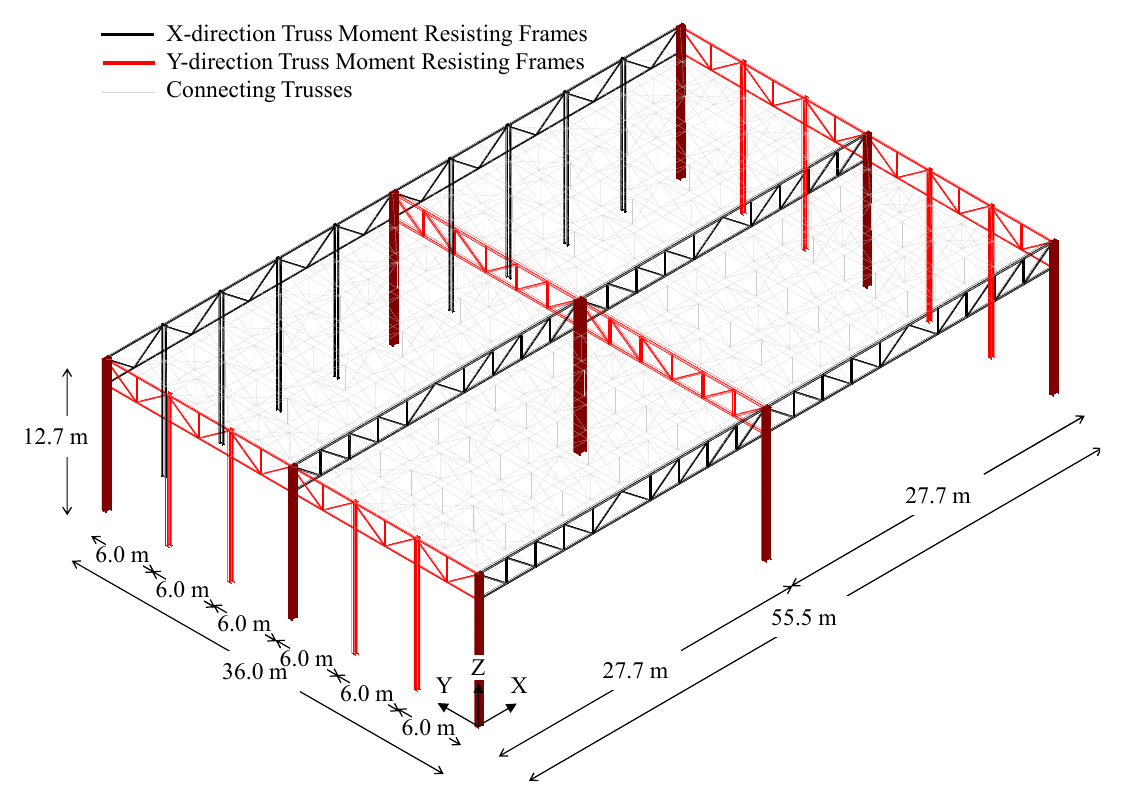
Figure 2. Geometrical features of the selected case-study and disposition of resisting systems in both directions.